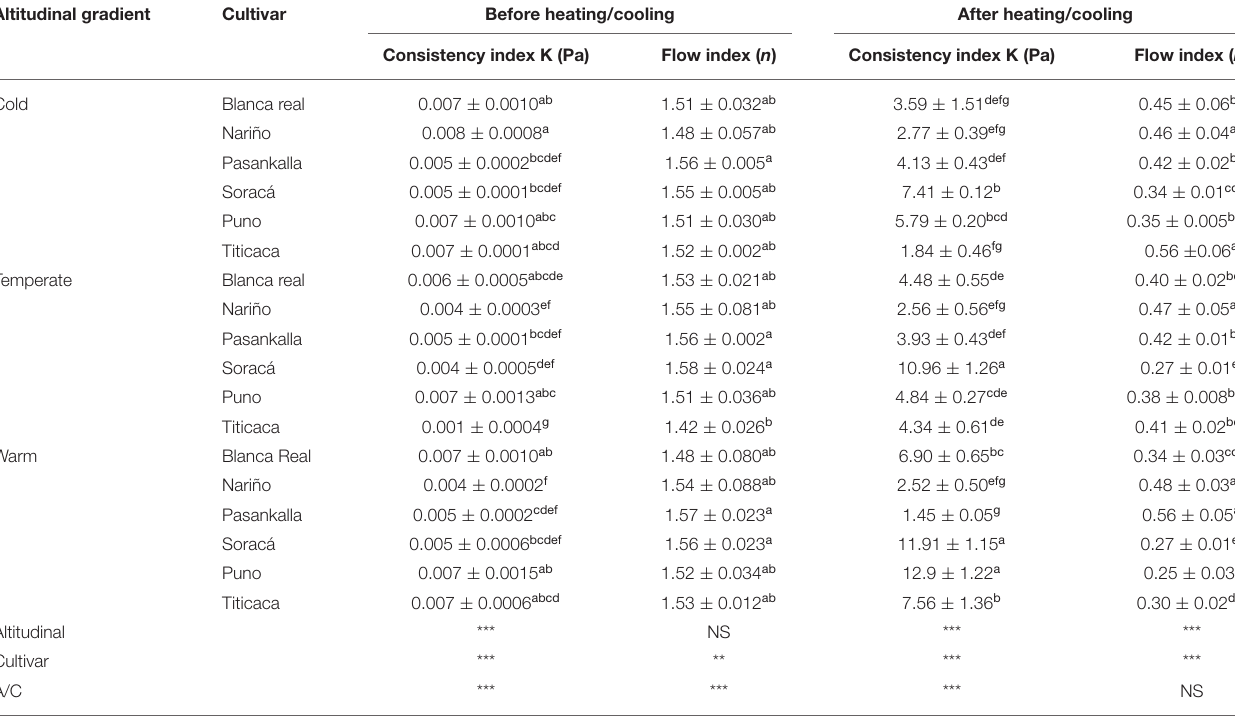
TABLE 6 | Behavior of quinoa flours at shear rate on flow rate and consistency. Altitudinal